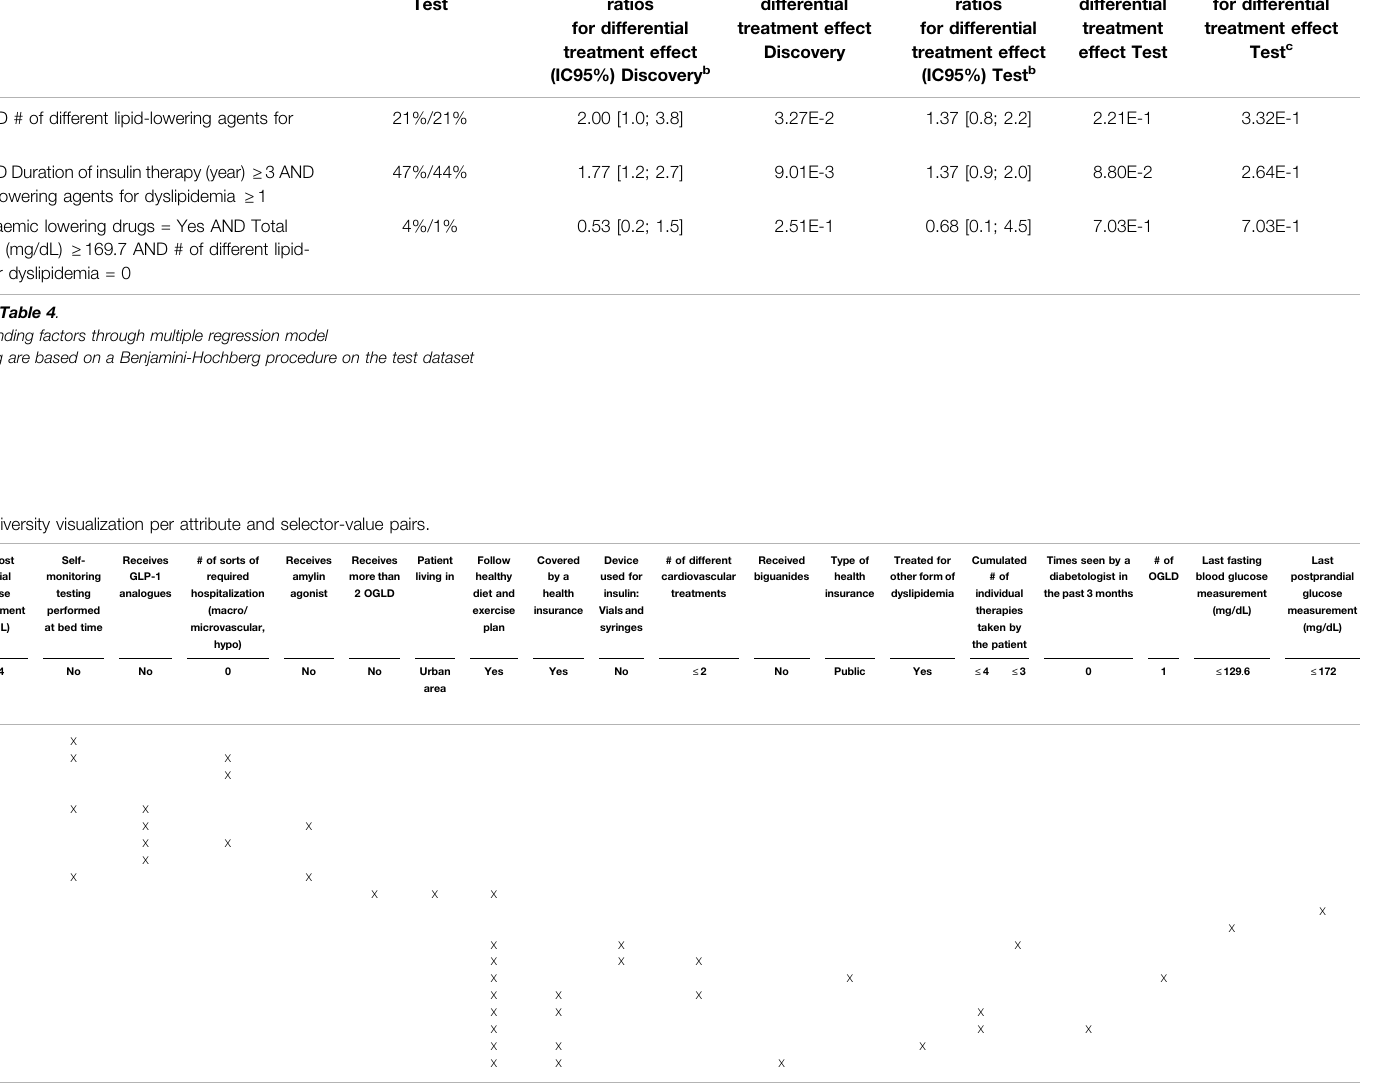
TABLE 6 | Credibility metrics from literature (used in Q-Finder) computed on Virtual Twins results. Subgroup Ranking a